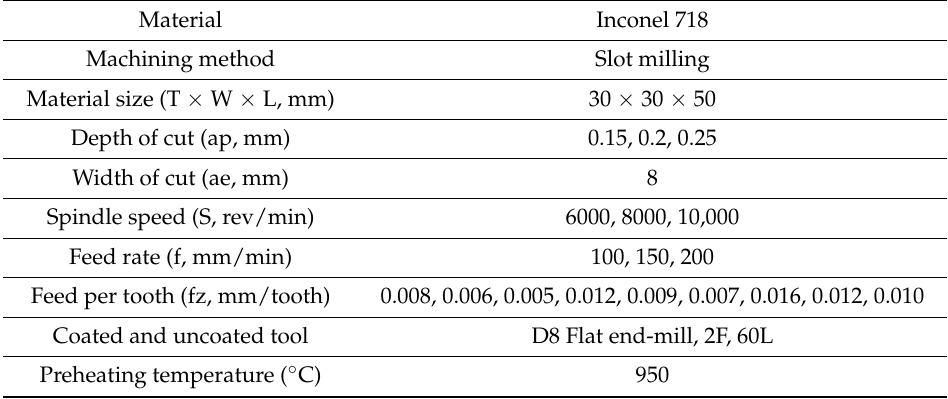
Figure 3. The experimental set-up. Table 1. The main cutting parameters.